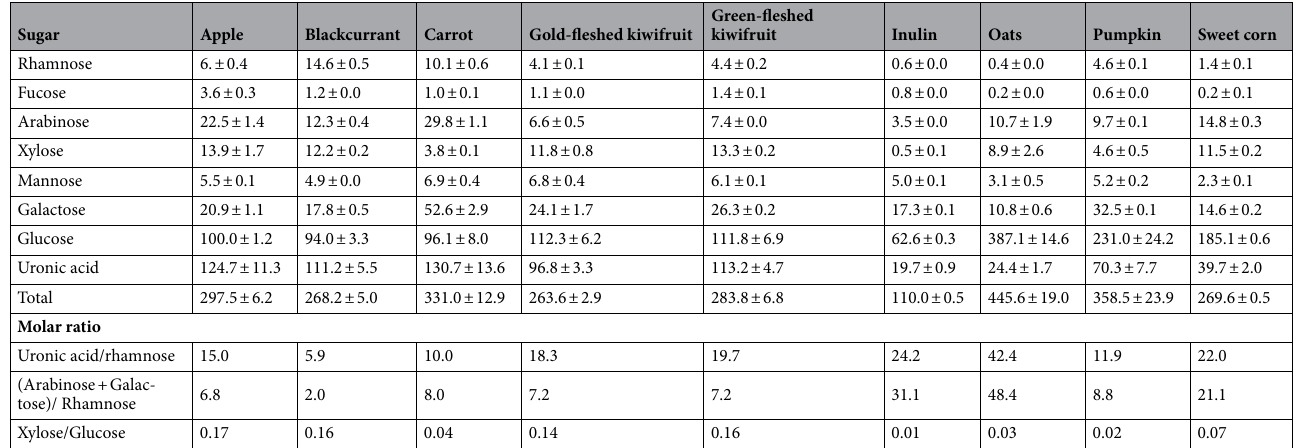
Table 2. Neutral sugar and uronic acid composition (µg/mg) and molar ratio analysis of pectic and xyloglucan-related sugars in the digesta from foods and inulin. Values (µg/mg of the freeze-dried material) are mean of two determinations, measured in duplicate. S.E. shown.